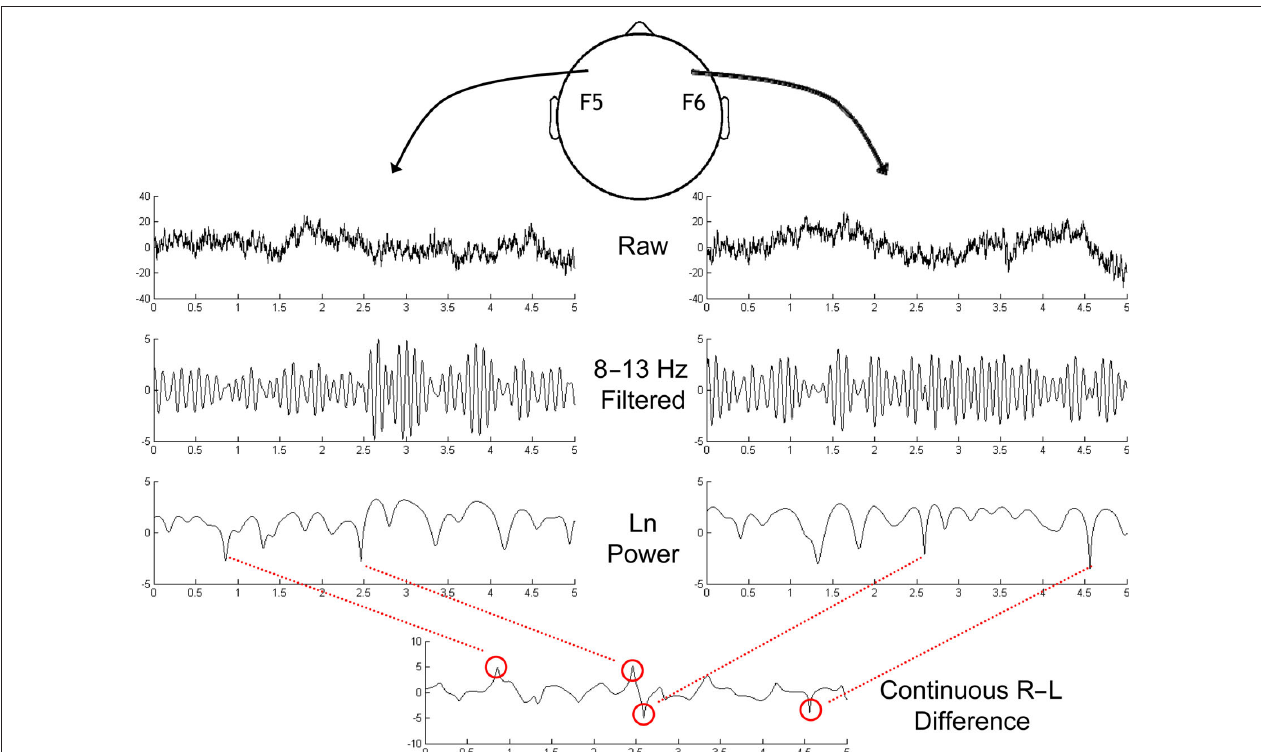
1 A subsequent re-analysis using a 5% cutoff yielded nearly identical